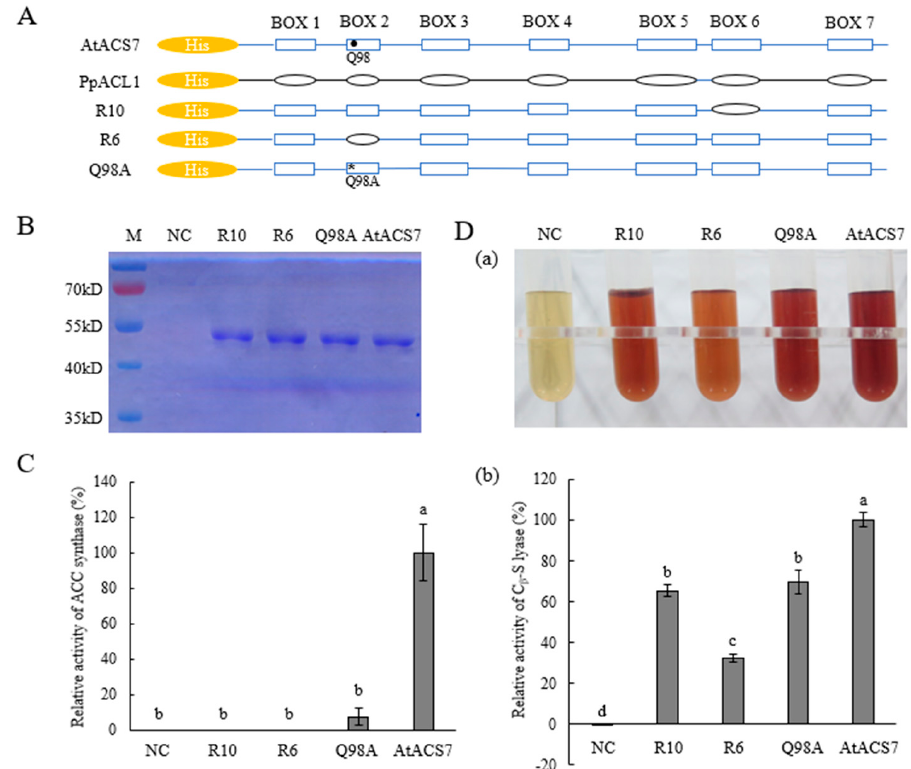
Figure 1. The chimeric protein R10 is a C β -S lyase (CSL) single-activity mutant of AtACS7. ( A ) General scheme for the constructions of R10, R6, and AtACS7 Q98A with His-tag. The black solid circle indicates position of the wild-type Q98 residue while the asterisk denotes position of its mutated form Q98A. ( B ) Purifications of His-tagged AtACS7, R10, R6, and AtACS7 Q98A proteins. ( C ) Measurements of in vitro ACS activities of R10, R6, and AtACS7 Q98A . ( D ) Determinations of in vitro CSL activities of R10, R6, and AtACS7 Q98A by measuring the pyruvate production generated from C β -S bond cleavage of L-cystine. Reddish-brown colorations of 2,4-dinitrobenzene-hydrazone generated from pyruvate and 2,4-dinitrobenzene were shown in panel ( a ) while quantitative measurements of CSL activity were displayed in panel ( b ). In both assays, the wild-type AtACS7 protein was used as a positive control and its ACS or CSL activity was normalized to 100%, respectively. Protein extracts from E. coli harboring the empty vector served as a negative control (NC). Lower-case letters indicate statistical signi fi cance ( α = 0.05). One-way ANOVA was followed with Tukey’s test. Data are mean ± standard error (SE) ( n = 3, biologically independent experiments). Exact p values were provided in Supplementary Table S1.